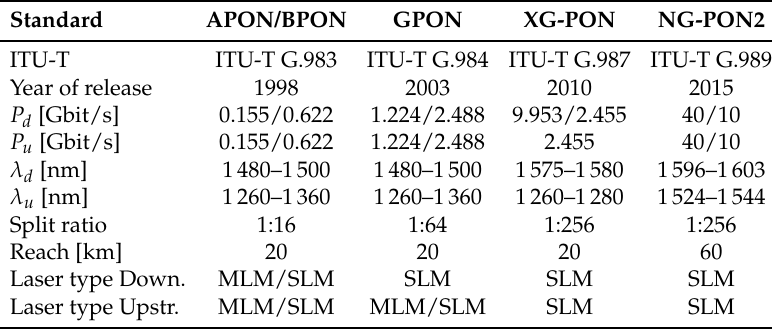
Table 1. Parameters of the ITU-T PONs.